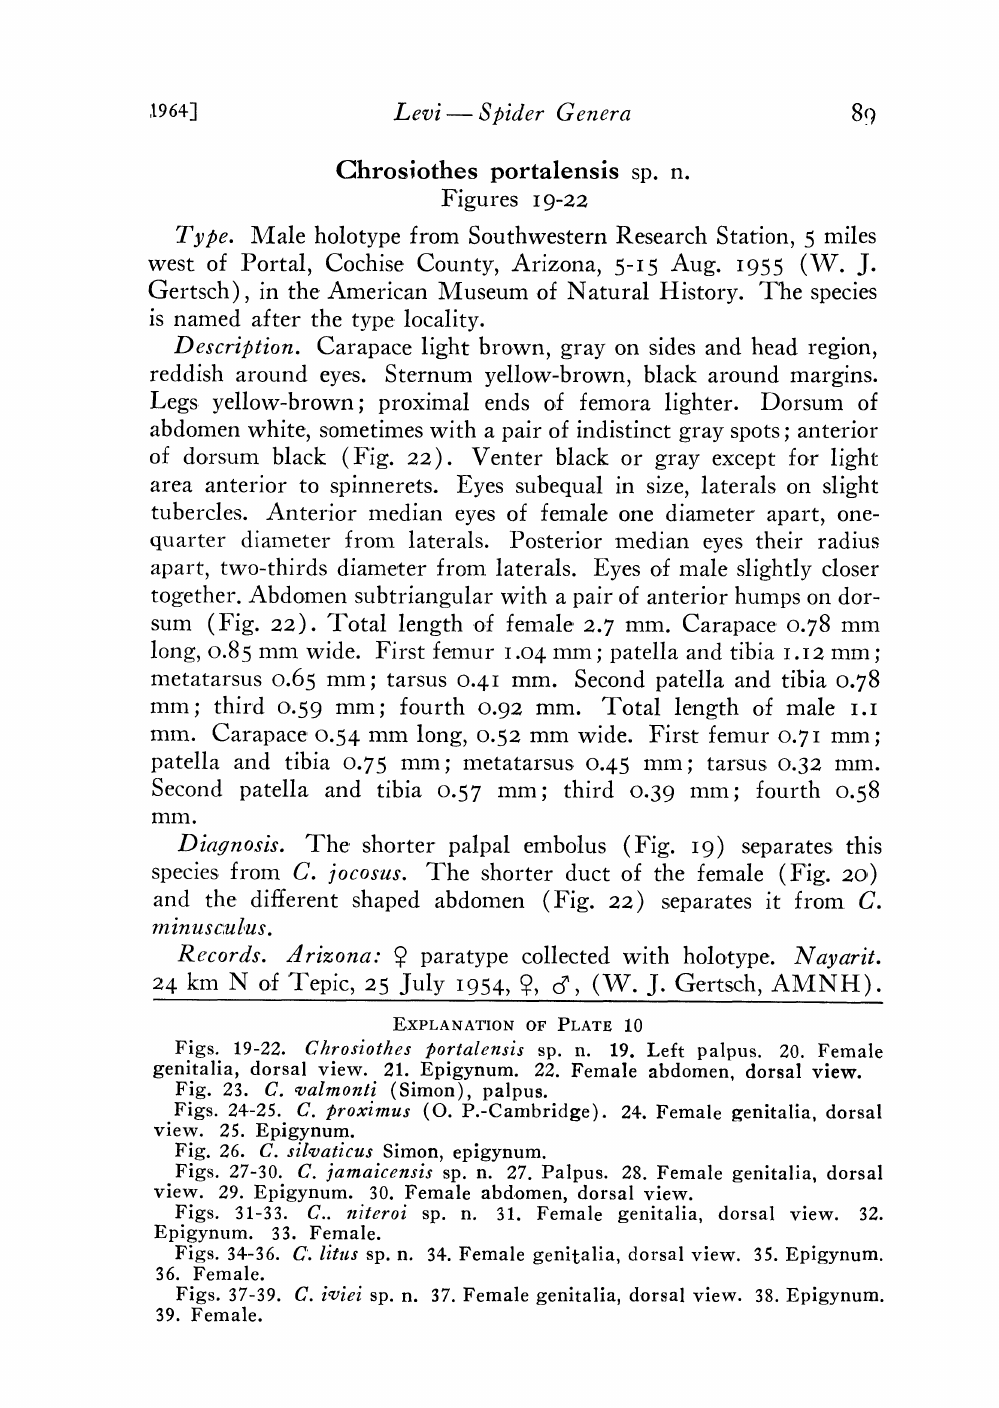
Figs. 37-39. C. iiei sp. n. 37. Female genitalia, dorsal view. 38. Epigynum. 39.